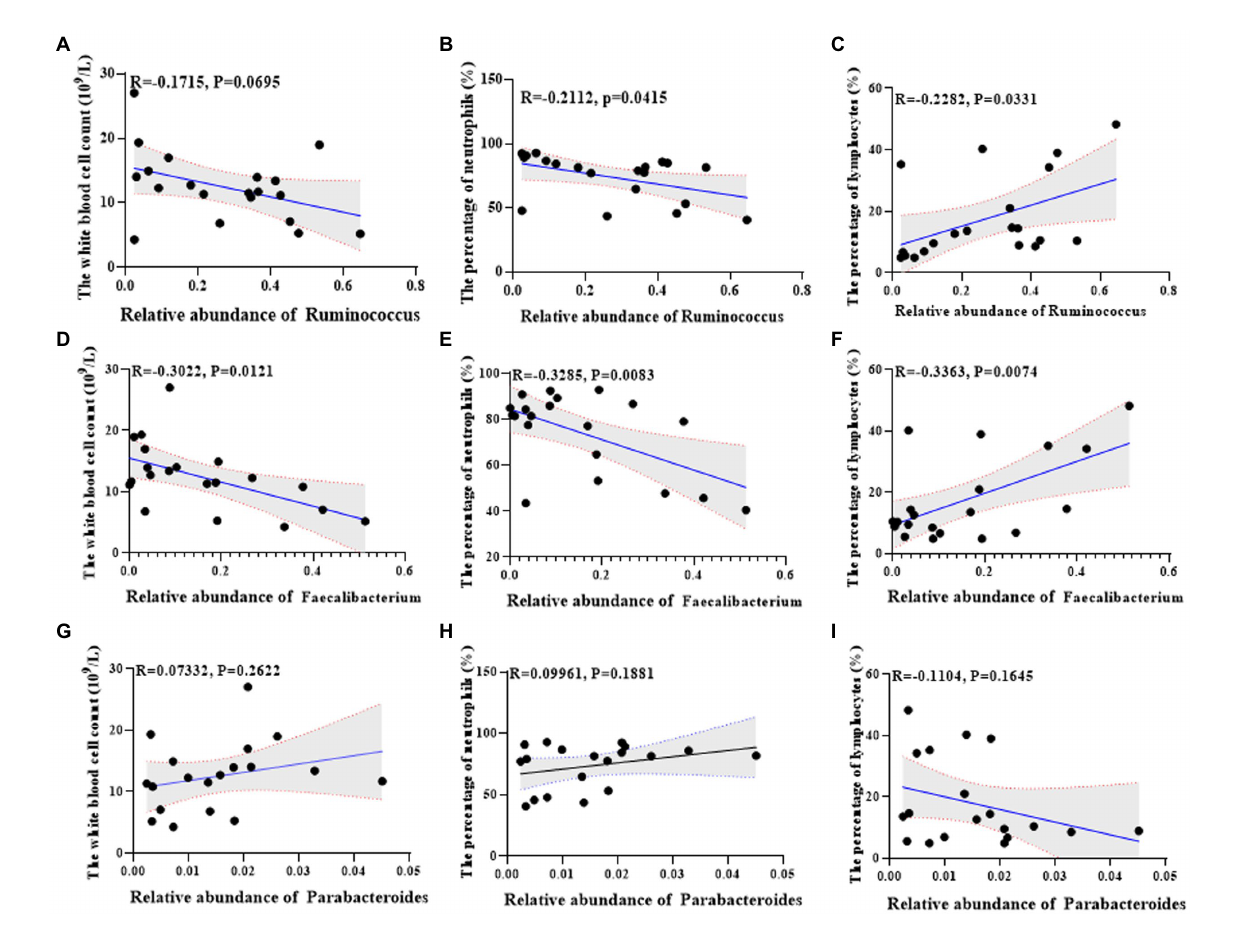
FIGURE 7 Univariate linear regression between Ruminococcus , Faecalibacterium and Parabacteroides relative abundance in fecal samples and the white blood cell count, the percentage of neutrophils and the percentage of lymphocytes of the matched mice. (A) Spearman correlation between Ruminococcus and the white blood cell count. (B) Spearman correlation between Ruminococcus and the percentage of neutrophils. (C) Spearman correlation between Ruminococcus and the percentage of lymphocyte cells. (D) Spearman correlation between Faecalibacterium and the white blood cell count. (E) Spearman correlation between Faecalibacterium and the percentage of neutrophils. (F) Spearman correlation between Faecalibacterium and the percentage of lymphocyte cells. (G) Spearman correlation between Parabacteroides and the white blood cell count. (H) Spearman correlation between Parabacteroides and the percentage of neutrophils. (I) Spearman correlation between Parabacteroides and the percentage of lymphocyte